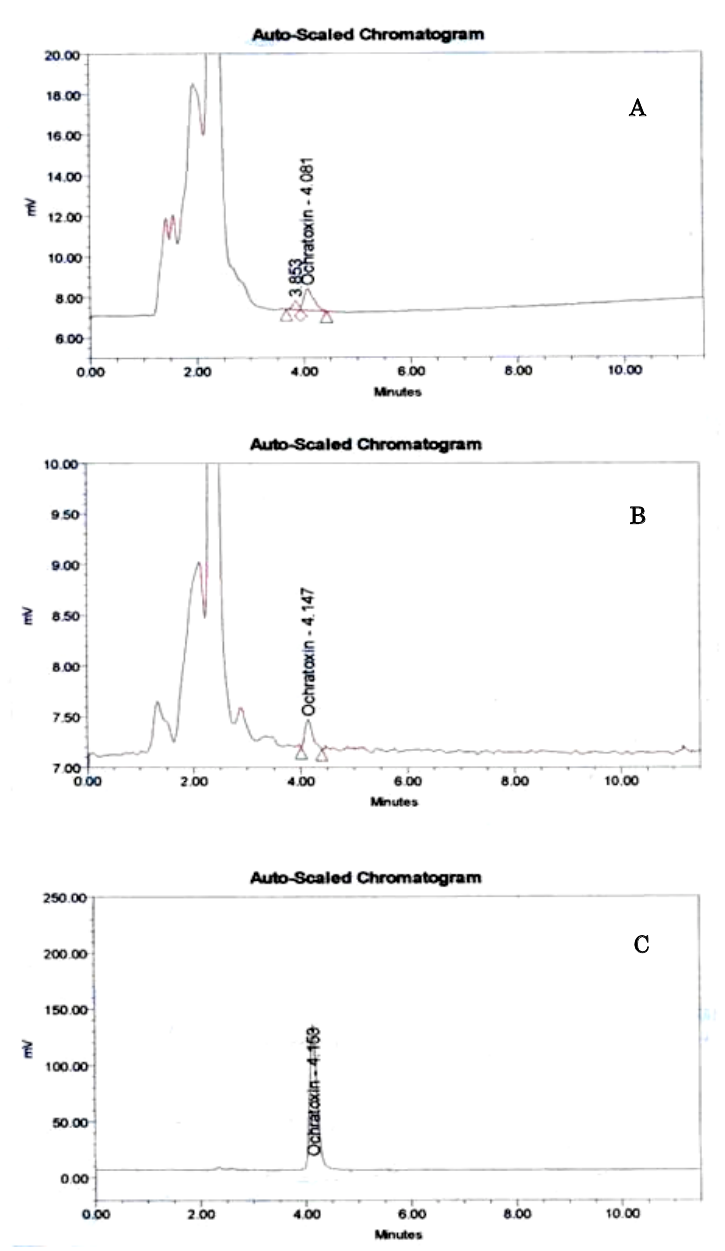
Figure 1. HPLC analyses of crude extracts of (A) - A. sulphureus (JS500) grown on CYB at the top; (B) - A. carbonarius (742); (C) - The following metabolite (ochratoxin) produced by this isolate can be identified using retention times and comparing UV spectra from analyses of standard Ohcratoxin Conidial heads are loosely radiate, with spore chains first formed, but quickly globose, smooth, 2.0-2.5 µm in adherent into numerous narrow, divergent and tangled diameter (Image 2). columns, 400-450µm in diameter and white in color. Conidiophores up to 1mm long, unbranched, smooth, colorless, stripes 500-650 x 5-7µm. Vesicles hyaline, globose, 12-26µm in diameter. Sterigmata in two series (uniseriate or biseriate). Primaries (uniseriate) 4.5-7.5 µm. Conidia fusiforms and slightly roughened when